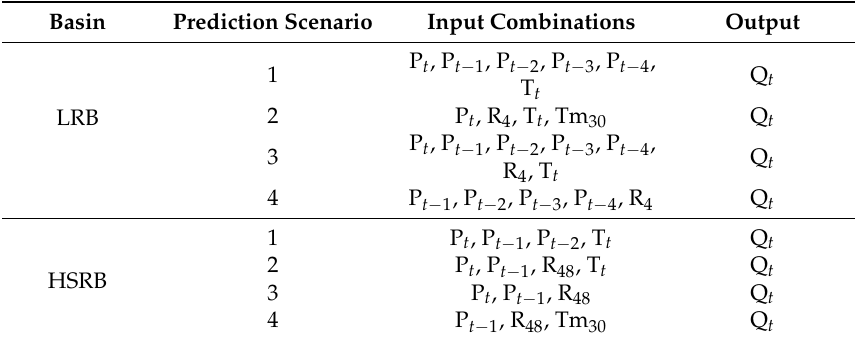
Table 7. Estimation scenarios for each basin.